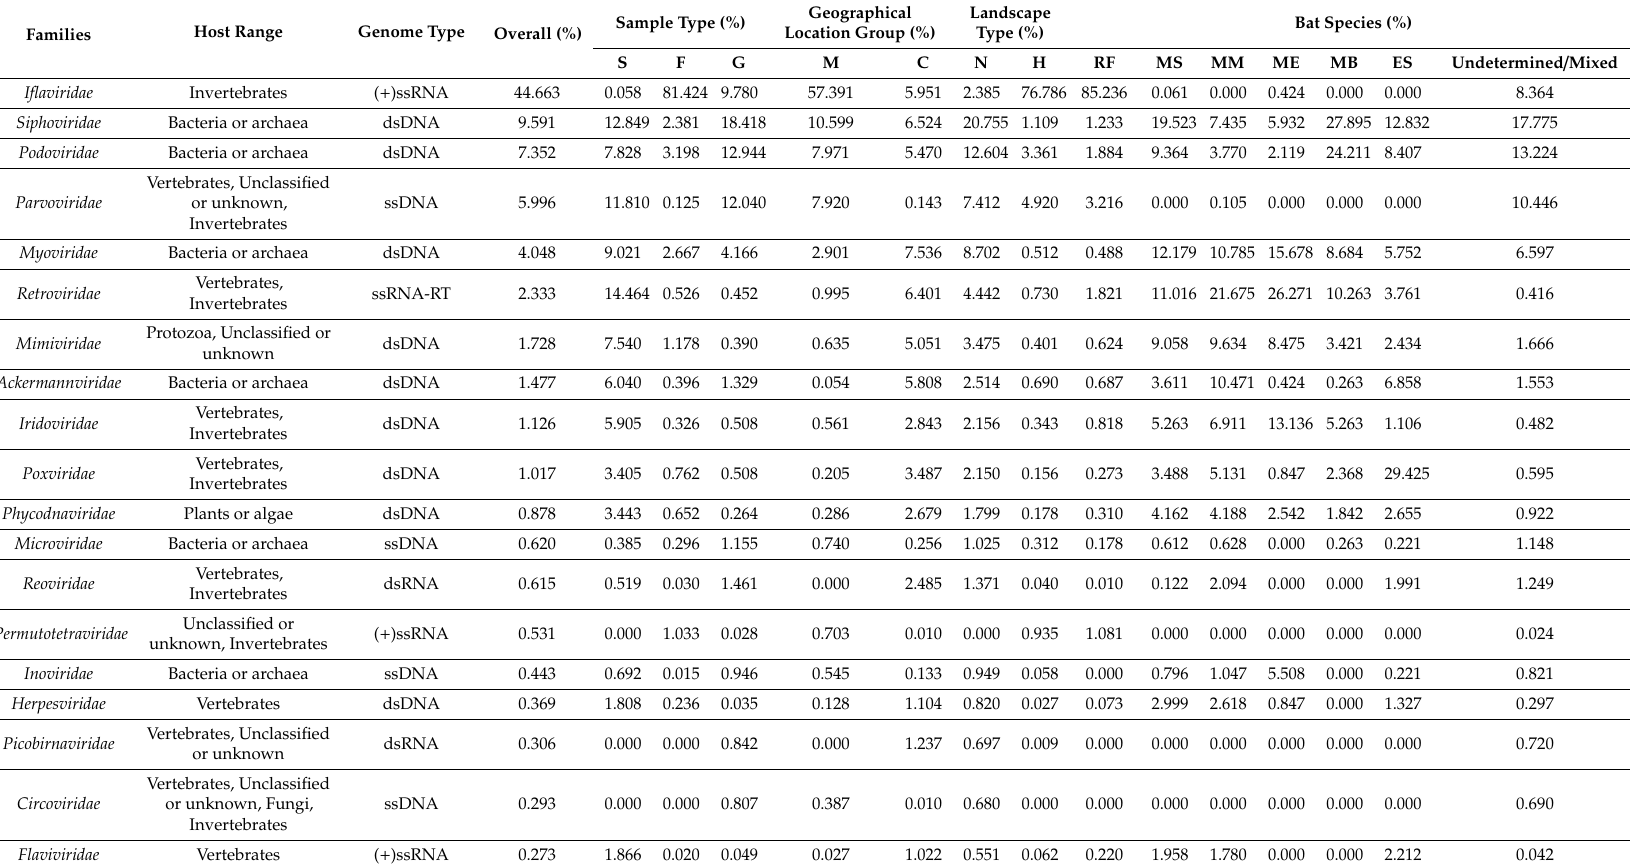
Table 2. Taxonomical (family level) compositions of the studied samples grouped according to various attributes. Table also denotes the Baltimore classifiers corresponding to each taxonomical family taxon and the host ranges, which were identified for the viral sequences contributing to the taxonomical family composite, based on the data in NCBI. The data are stratified according to sample type (S—oral swab, F—feces, G—guano), geographical location (M—Mediterranean, C—continental), landscape type (N—natural, H—with human activity / anthropogenic) and according to bat species (MS— M. schreibersii , MM— M. myotis , RF—